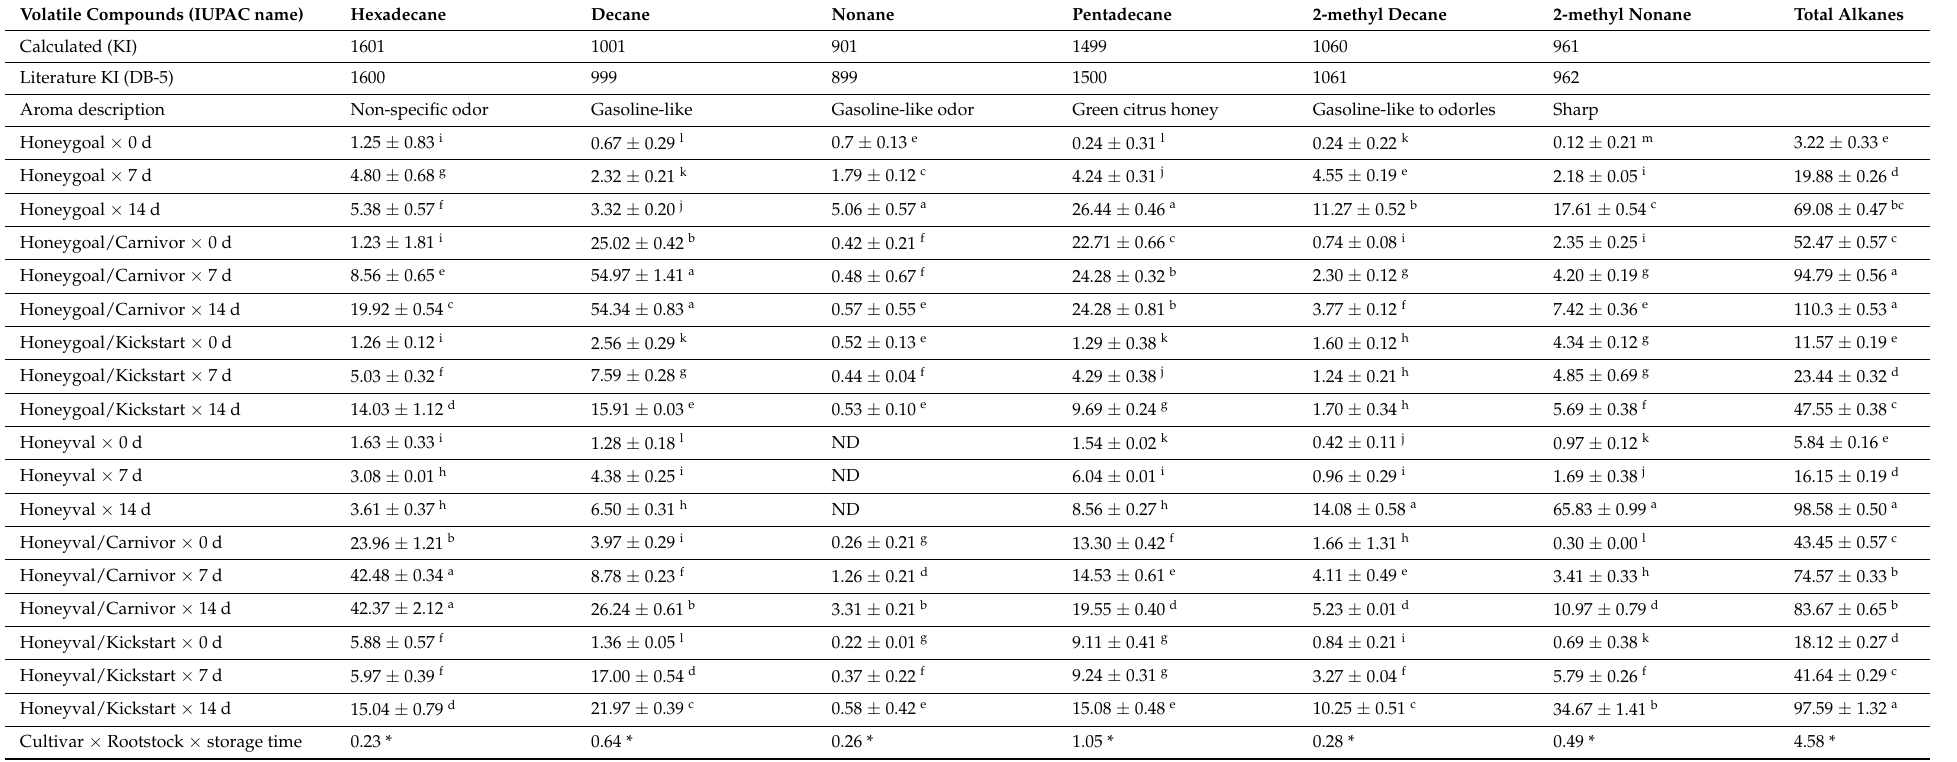
Table 4. Changes in volatile compounds (alkanes) of honeydew melon cultivars influenced by grafting and postharvest storage ( µ